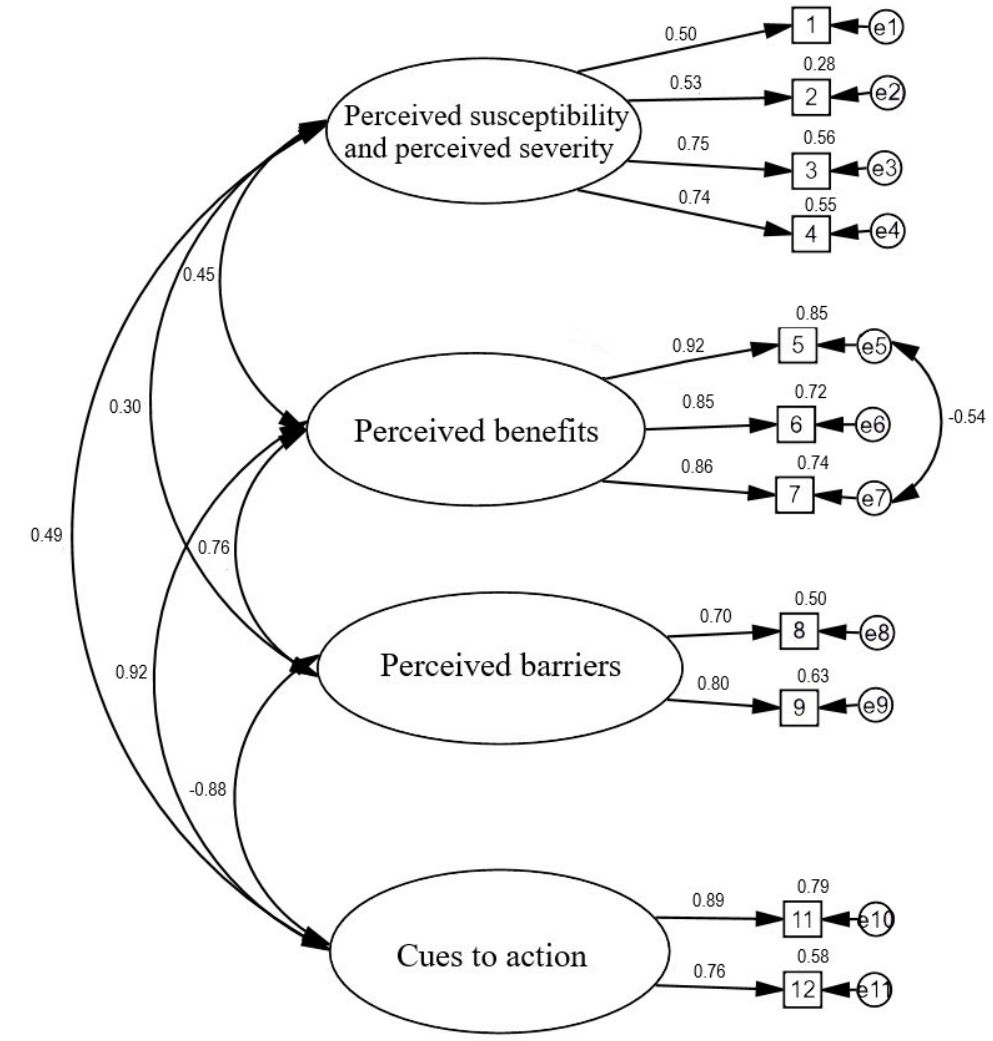
Figure 1. Confirmatory factor analysis for the HBM scale.